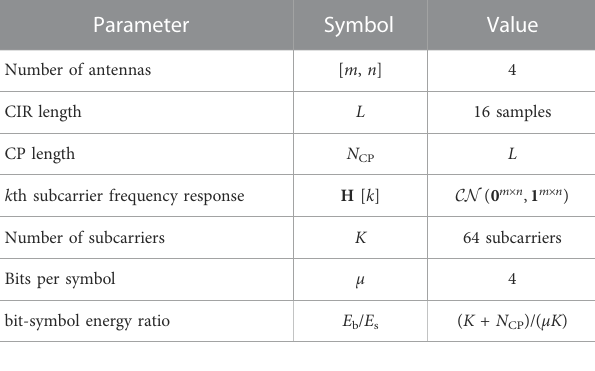
FIGURE 8 MSE versus BCRB for the investigated linear estimators. TABLE 5 Parameters for the non-iterative and uncoded system simulation.